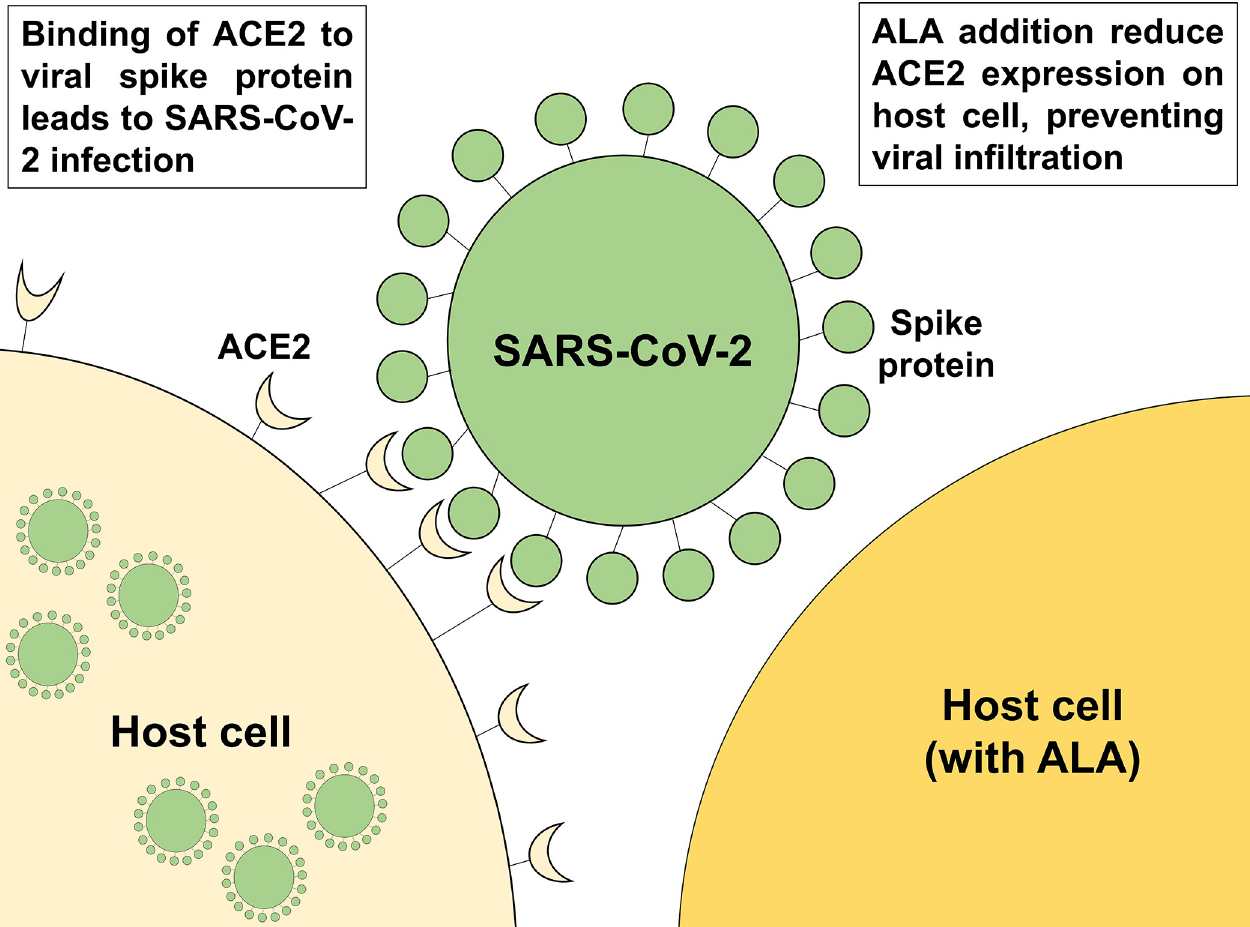
Fig 7. Schematic illustration on the effect SARS-CoV-2 infectivity towards host cell treated with and without ALA. ALA suppressed the ACE2 expression in host cells which might prevent binding of SARS-CoV-2 to host cells.